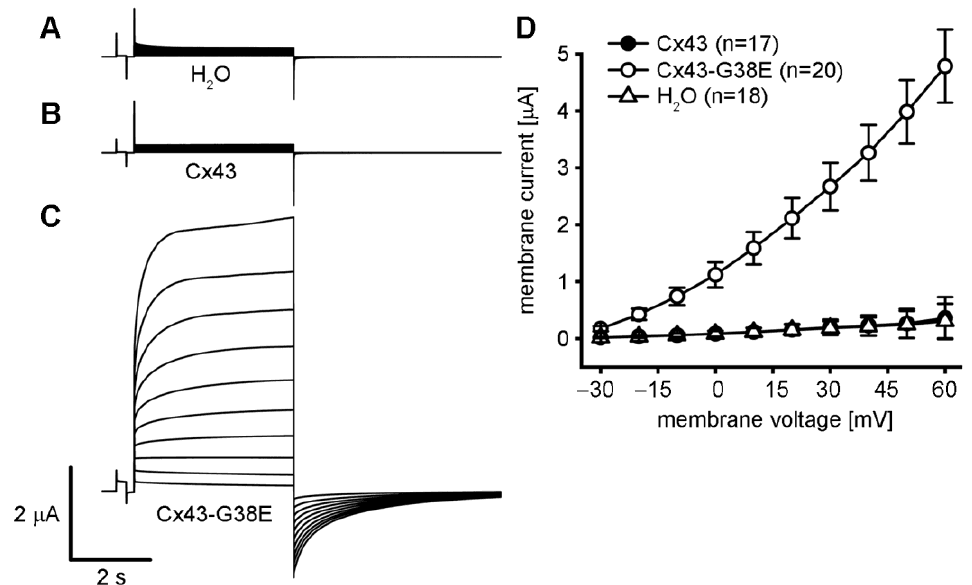
Figure 2. The Cx43-G38E mutation forms active connexin hemichannels. Single oocytes were clamped at –40 mV and subjected to voltage pulses ranging from –30 to +60 mV in 10 mV steps. ( A ) H 2 O and ( B ) wild-type Cx43 injected oocytes displayed negligible membrane currents. ( C ) Cx43-G38E expressing oocytes had much larger hemichannel currents than wild-type Cx43. ( D ) Peak currents from each pulse were plotted as a function of membrane voltage. Peak currents in wild-type Cx43 (filled circles), or H 2 O injected (open triangles) oocytes were negligible at all tested voltages. Cx43- G38E (open circles) expressing cells exhibited significantly increased peak currents at all voltages compared to either control or wild-type Cx43 oocytes. Data are the mean ± SE.